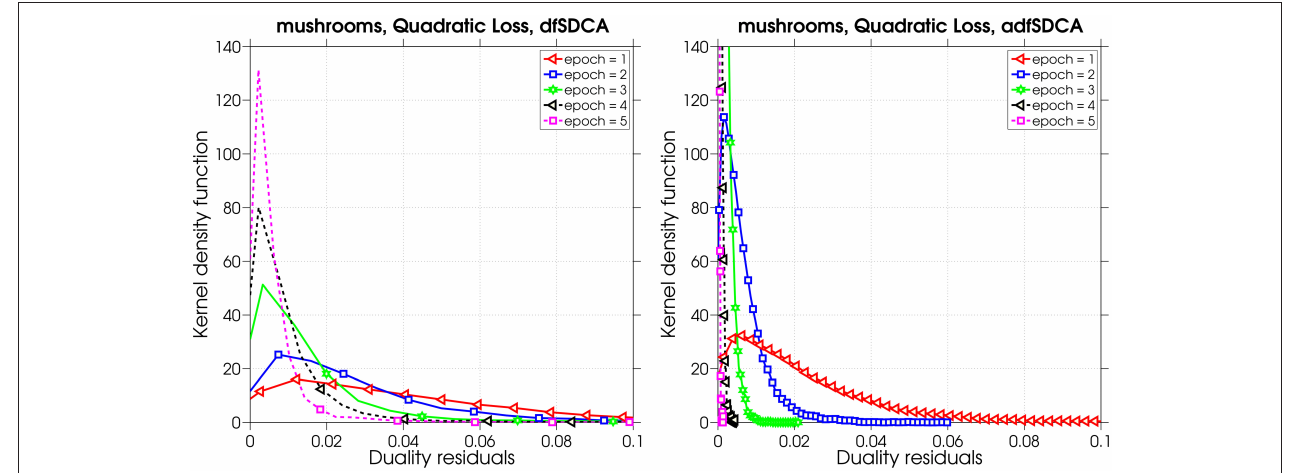
FIGURE 4 | Comparing the absolute value of the dual residuals for dfSDCA and adfSDCA over five epochs.